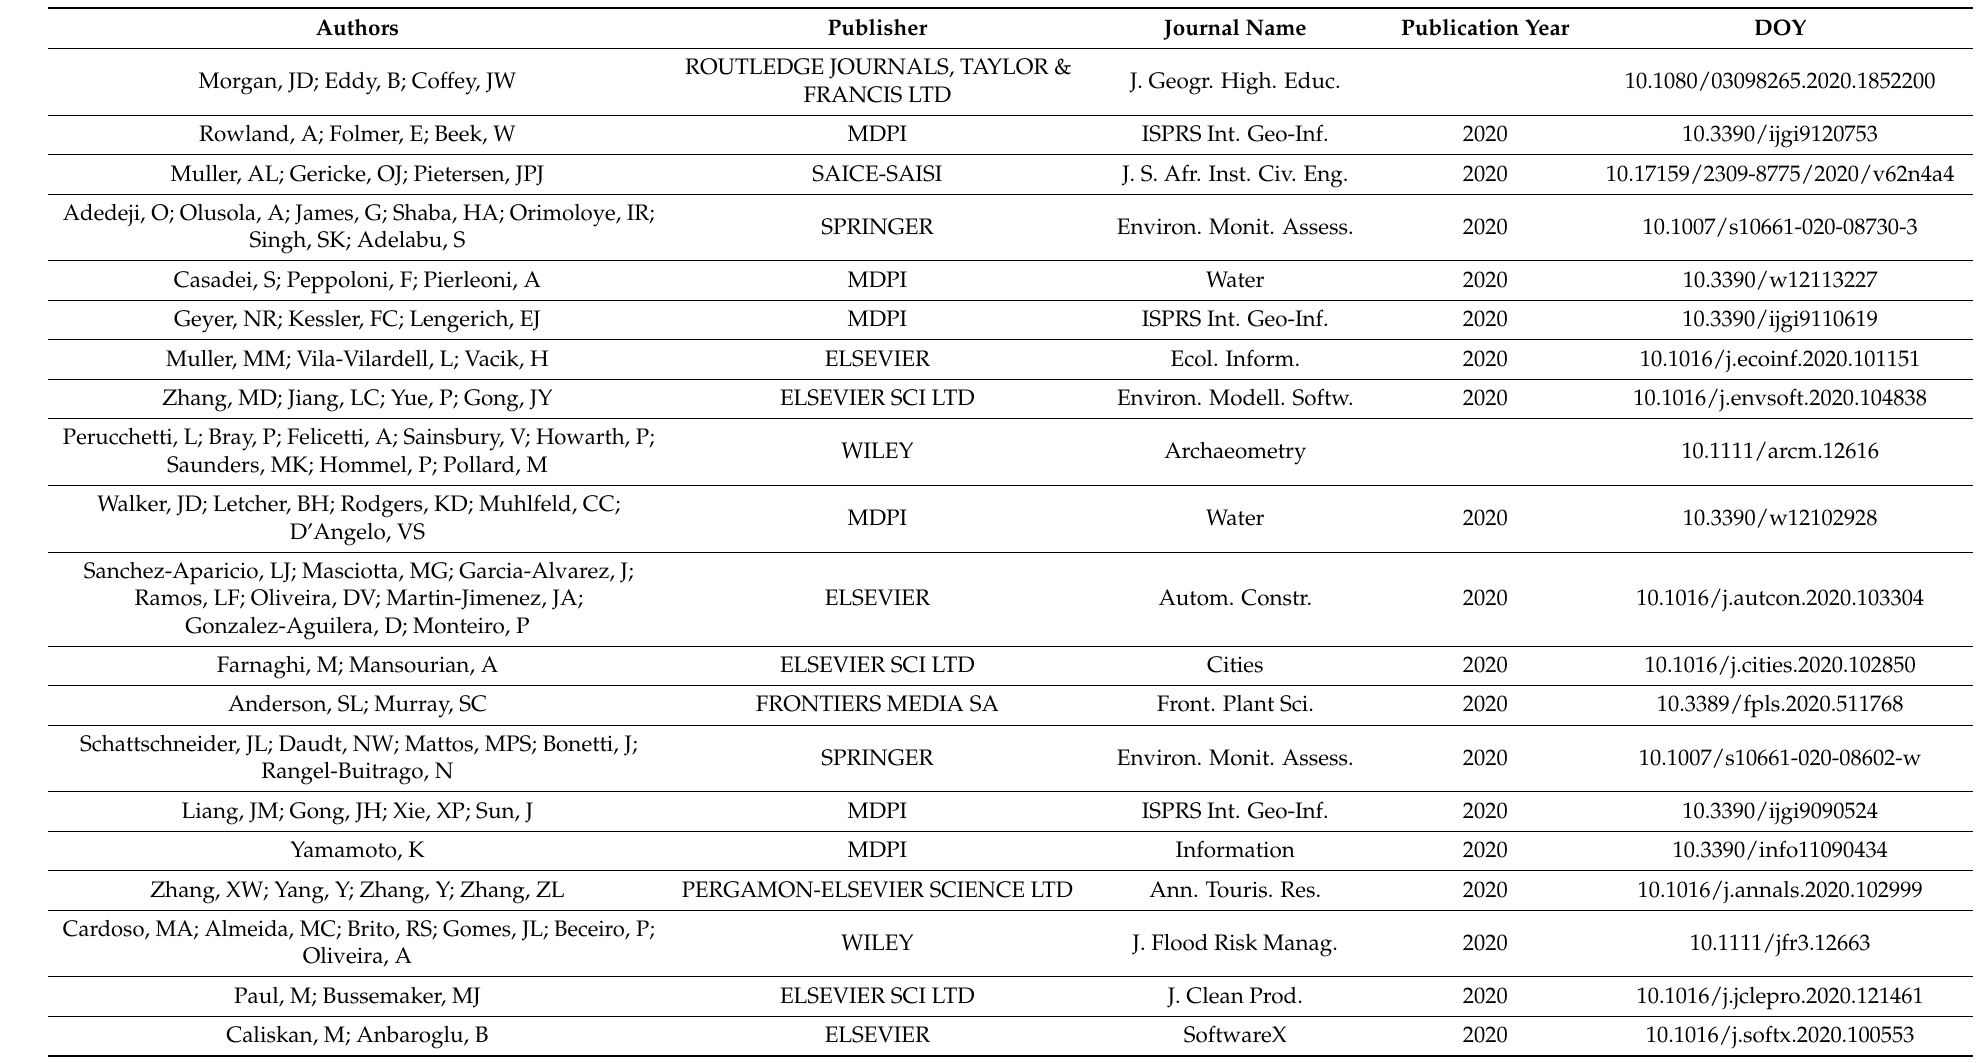
Table A1. The 391 publications found in the WoS, including the authors, publisher, publication year and DOY.